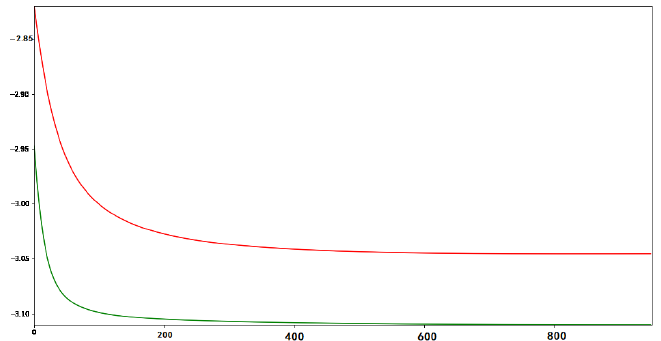
Figure 11. Inverse problem 2. Numerical solution. log J ( r 1 , r 2 ) on n th iteration. Red line is Test 2. Green line is Test